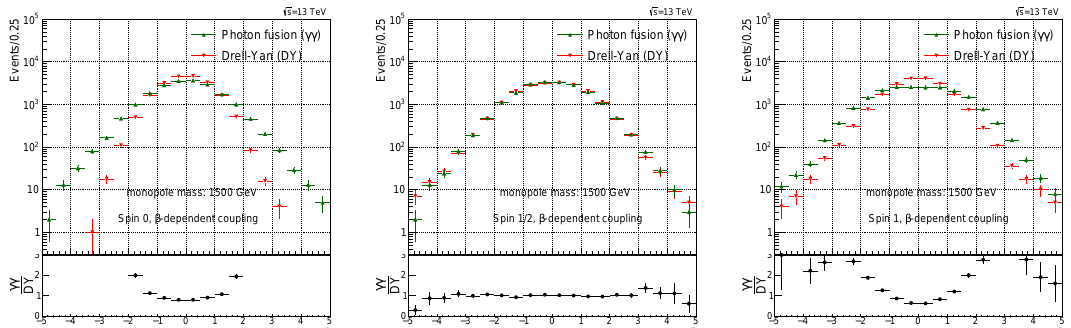
Figure 5. Pseudorapidity ( η ) distribution comparison between the photon fusion and Drell–Yan processes for spin 0 ( left ), spin 1 / 2 ( middle ), and spin 1 ( right ) monopoles. Here, β -dependent coupling has been used. For the PDFs, NNPDF23 was used for the Drell–Yan process and LUXqed was used for the photon fusion process [10].